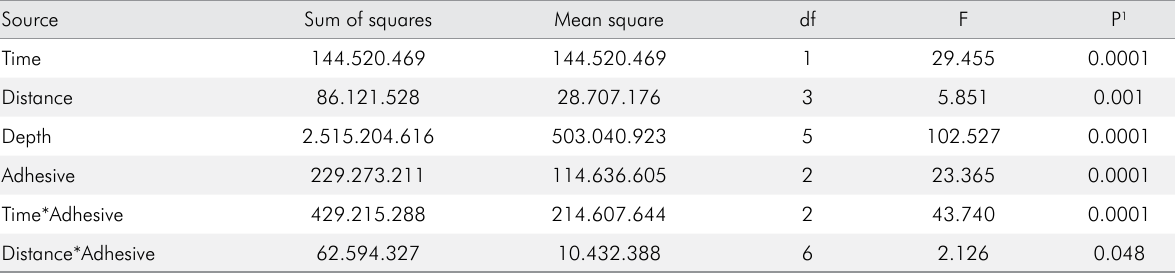
Table 1. Univariate analysis of variance results for